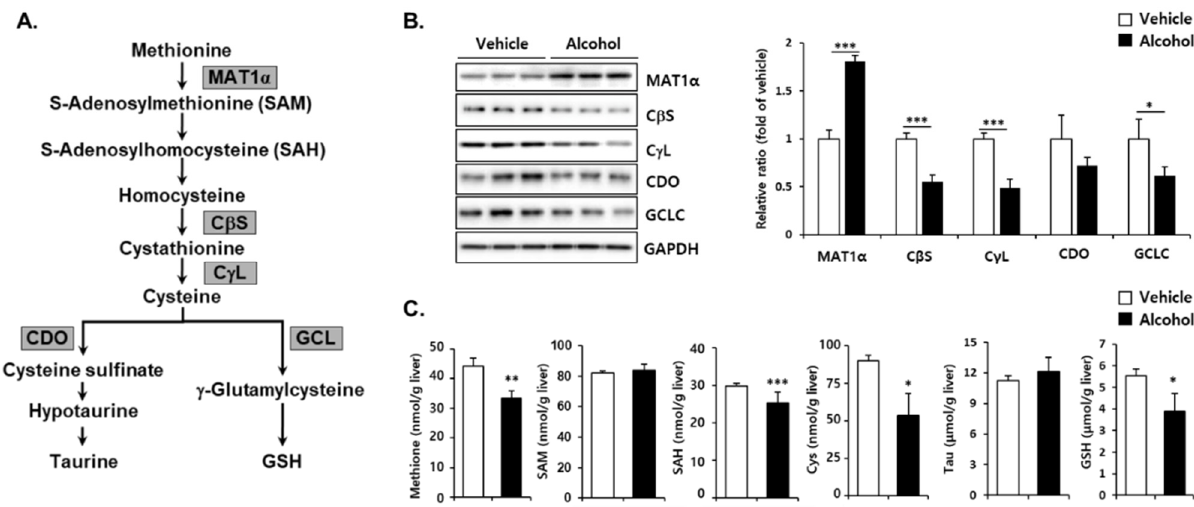
Figure 3. Alcohol changes the hepatic enzymes involved in trans-sulfuration pathway and sulfur-containing metabolites in the liver of mice. Three consecutive doses of alcohol (5 g/kg, n = 5) or vehicle ( n = 5) were administered orally to mice at 12 h intervals. The mice were euthanized 12 h after the last alcohol treatment (designated as APAP 0 h). ( A ) Sulfur-containing amino acid metabolism. ( B ) Methionine adenosyltransferase (MAT1 α ), cystathionine β -synthase (C β S), cystathionine γ -lyase (C γ L), cysteine dioxygenase (CDO) and glutamate cysteine ligase catalytic subunit (GCLC) protein levels were evaluated by immunoblotting in the liver at APAP 0 h. GAPDH was used as the loading control. The expression levels of proteins were normalized to that of GAPDH. ( C ) Hepatic concentrations of methionine, S -adenosylmethionine (SAM), S -adenosylhomocysteine (SAH), cysteine, taurine and glutathione (GSH) were measured in the liver at APAP 0 h. The results are expressed as the mean ± SD. *, **, *** Significantly different from the vehicle group (Student’s t test, p < 0.05, p < 0.01 and p < 0.001, respectively).